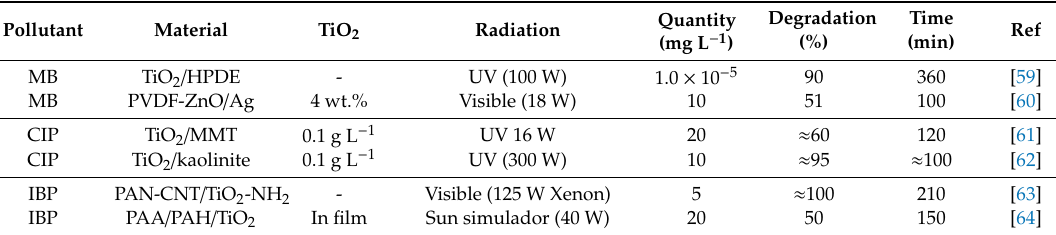
Table 2. Comparison of results with related works that used immobilised nanocatalysts on the degradation of MB, CIP, and